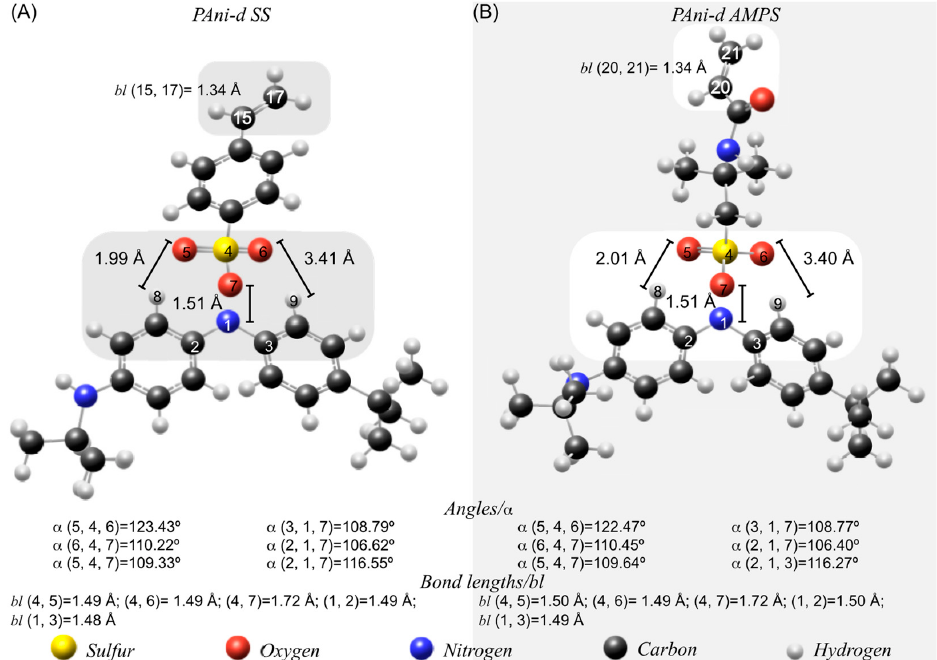
Figure 4. Geometric structure of ( A ) polyaniline dimer doped with styrene sulfonate (PAni-d SS) and ( B ) polyaniline dimer doped with 2-acrylamide-2-methyl-1-propanesulfonate (PAni-d